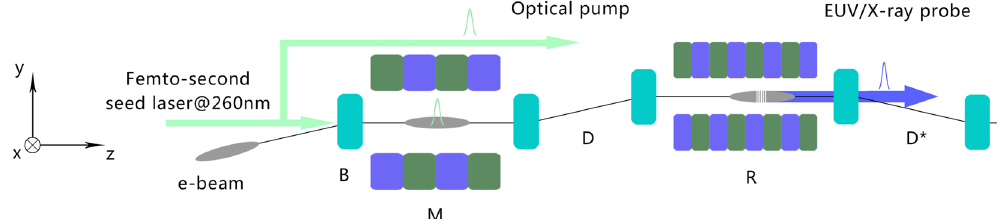
Figure 1. Schematic layout of the proposed scheme. The electron beam first passes through a bending magnet (B) to get an angular dispersion. This electron beam interacts with a femto-second seed laser pulse at 260 nm in the first undulator (M) to generate an energy modulation. The dogleg (D) is adopted to convert the energy modulation into coherent microbunching. Then the pre-bunched electron beam will be sent into the second undulator (R) for high harmonic generation. The second dogleg (D * ) is used to compensate the transverse dispersion induced by the first dogleg. The seed laser can be split in two branches and one of them together with the EUV/X-ay radiation pulse can be applied for the femto-second pump-probe experiments at storage